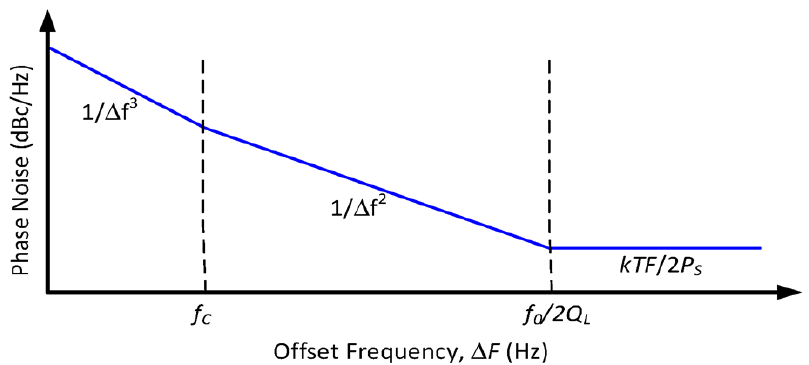
Figure 3. Typical phase noise power spectral density (single sided).